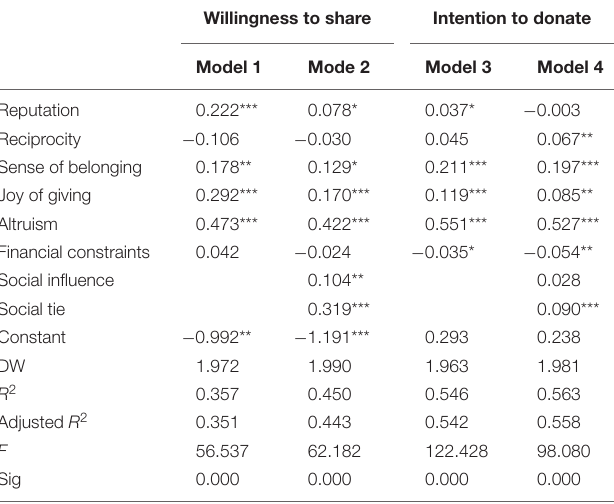
TABLE 4 | Regression predicting WTS and